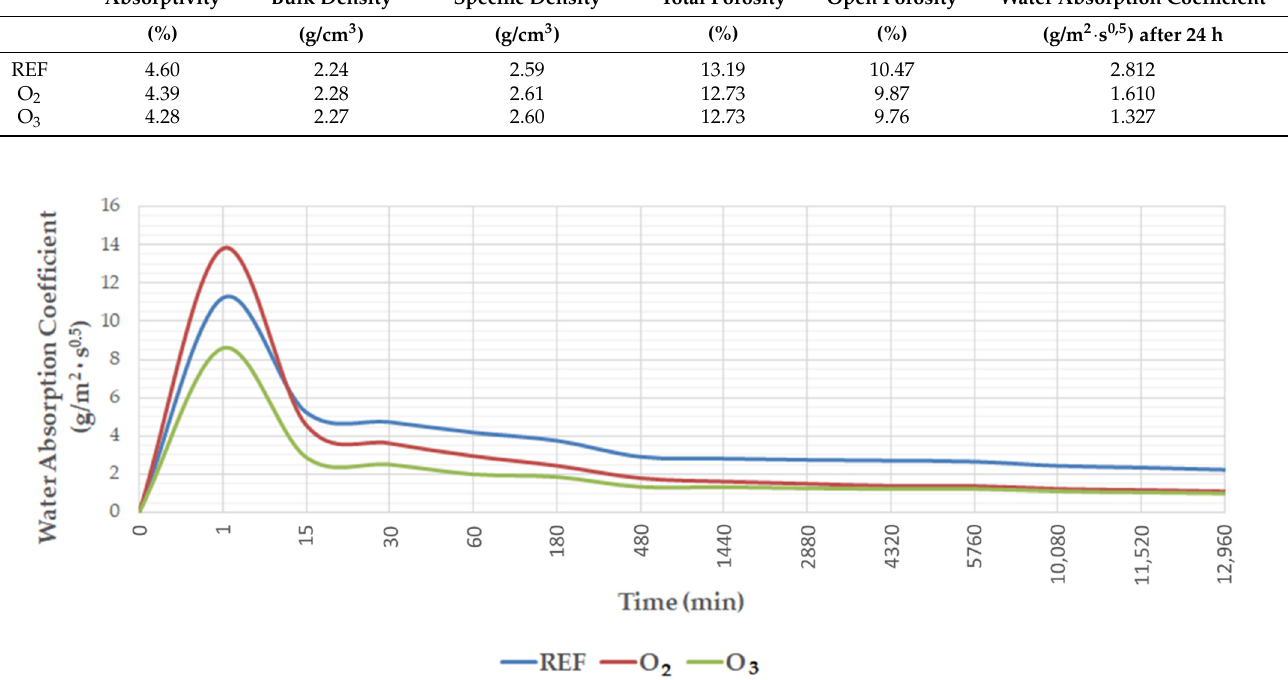
Figure 5. Capillary absorption of concrete as a function of time.